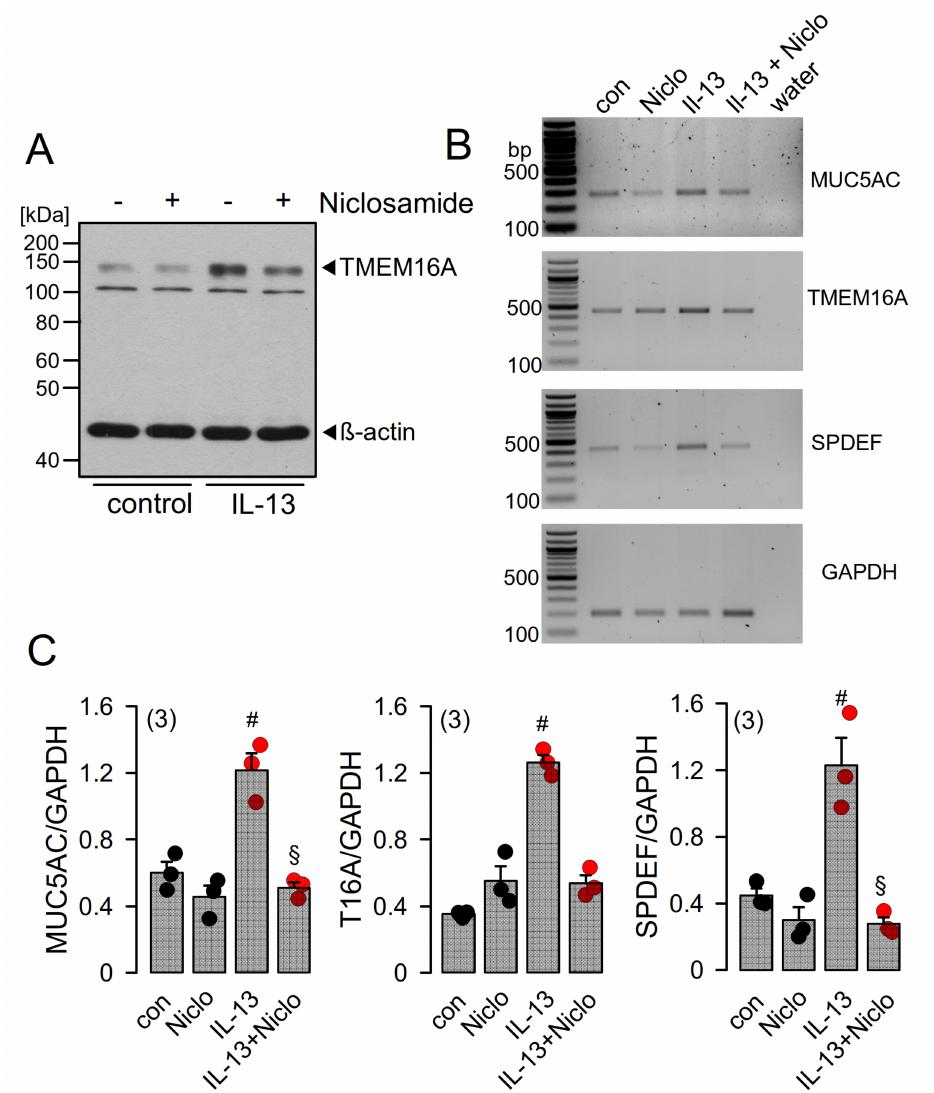
Figure 6. Niclosamide inhibits expression of MUC5AC and SPDEF in Calu-3 cells. ( A ) Western blot indicating upregulation of TMEM16A in Calu-3 cells by IL-13 (20 ng/mL, 72 h) and inhibition of expression by niclosamide (1 µ M). Blots were performed in triplicates. ( B ) RT-PCR analysis of the expression of MUC5AC, TMEM16A, and SAM pointed domain-containing ETS transcription factor (SPDEF) in Calu-3 airway epithelial cells. SPDEF is an integrator of goblet cell differentiation and pulmonary Th2 inflammation. ( C ) Low cycle numbers (20 × ) were chosen for quantification of expression by relating specific signals to expression of the housekeeper protein GAPDH. IL-13 (20 ng/mL) leads to upregulation of expression of MUC5AC, TMEM16A, and SPDEF. Niclosamide (Niclo, 1 µ M, 72 h) strongly inhibits expression of MUC5AC, TMEM16A, and SPDEF. Mean ± SEM (number of assays). #,§ significant increase by IL-13 and inhibition by niclosamide, respectively ( p < 0.05,